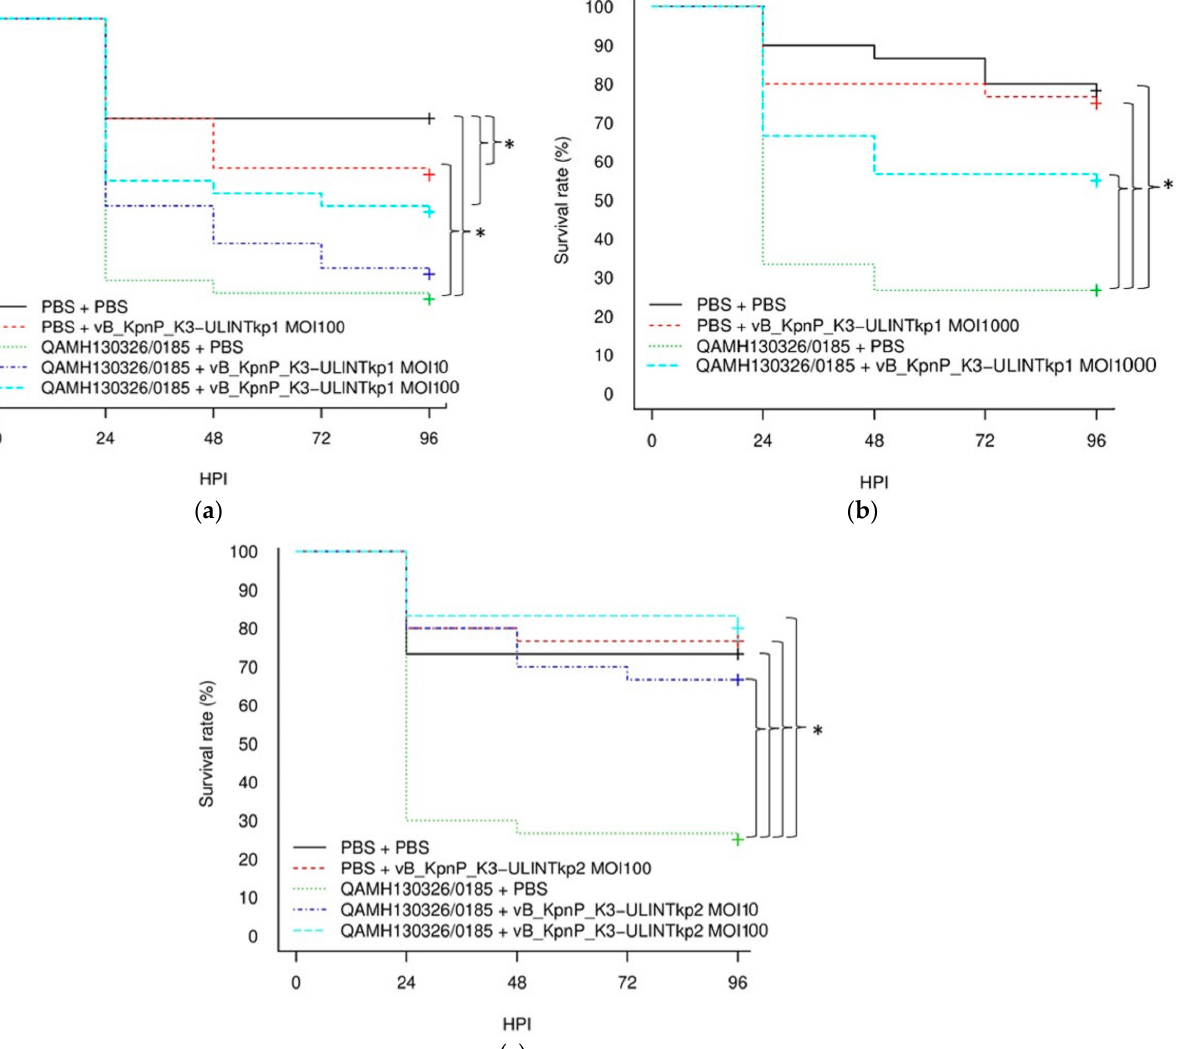
Figure 7. Kaplan–Meier survival curves of the experiments with G. mellonella larvae inoculated with K. pneumoniae QAMH130326/0185 or PBS and treated with vB_KpnP_K3-ULINTkp1 ( a ) for MOI = 10, MOI = 100 and ( b ) for MOI = 1000 or vB_KpnP_K3-ULINTkp2 ( c ) or PBS 1 h later. Each group contained 30 larvae. MOI: multiplicity of infection; HPI: hours post inoculation; p -value (*) ≤ 0.05 (Log-rank tests).